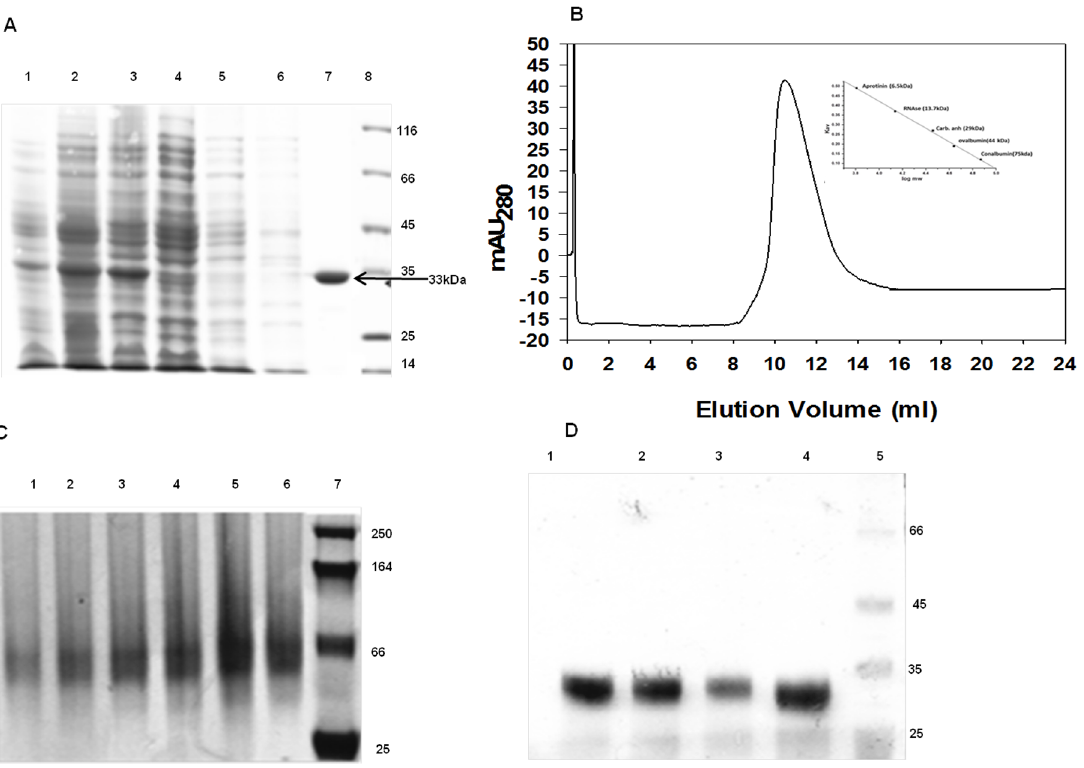
Figure 3. Over-expression, purification, size exclusion chromatography and trypsin digestion of of L.donovani ADL. (A) 12% SDS PAGE of the purified L. donovani ADL. M-unstained protein marker; lane 1-unduced; lane 2-induced lane 3-load; lane 4-flow through; lane 5- equilibration; lane 6-wash; lane 7-elution of L. donovani ADL showing single band after metal affinity chromatography. (B) Size exclusion chromatography profile of L. donovani ADL showing protein elution at 10.4 ml on a Superdex 75 column, corresponding to 66 kDa molecular weight i.e. dimer. (C) Confirmation of the dimer by Native Polyacrylamide Gel Electrophoresis. (D) Trypsin assisted limited proteolysis analysis of L. donovani ADL at different time intervals showing that trypsin has no effect on L. donovani